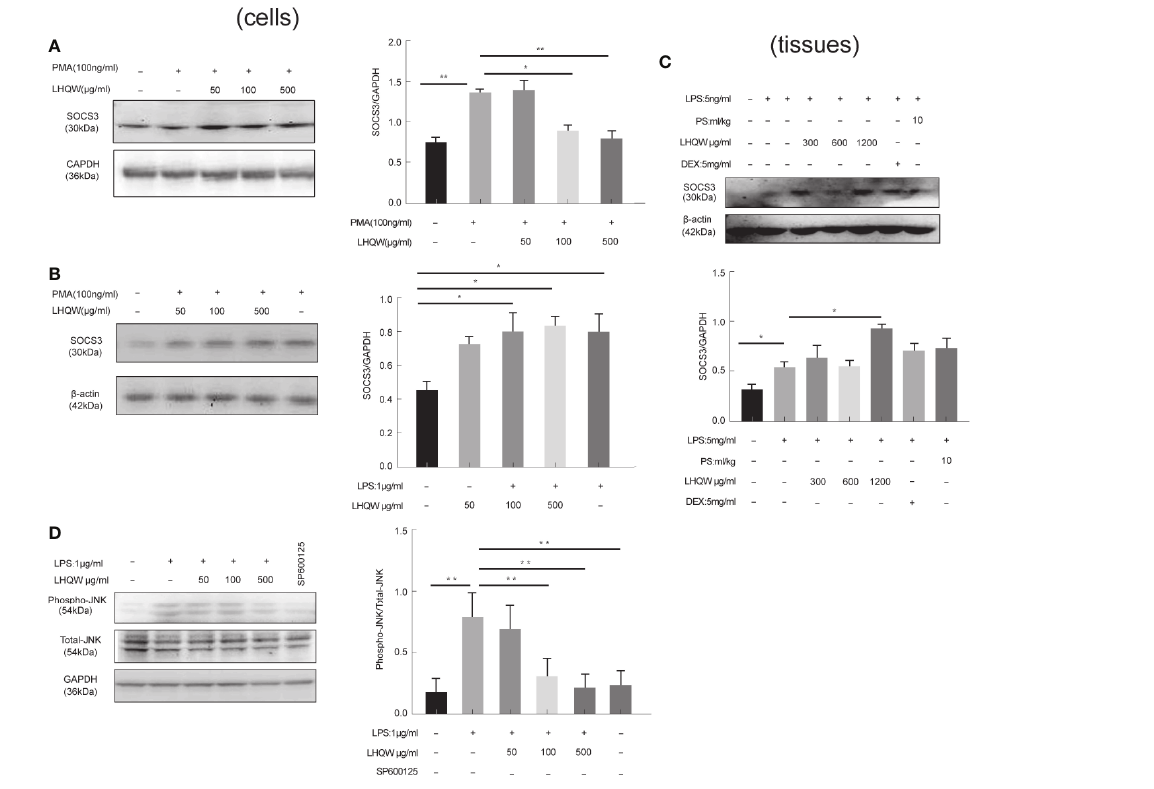
FIGURE 5 | Lian Hua Qing Wen capsule (LHQW) speci fi cally inhibited endoplasmic reticulum stress (ERS) through c-Jun N-terminal kinase (JNK) pathway activation. Bronchoalveolar lavage fl uid (BALF) samples were centrifuged, and pulmonary macrophages were isolated with the adherent method. THP1 cells were fi rst induced by PMA to differentiate into macrophages, and subsequently treated with LHQW and LPS for another 24 h. RAW 264.7 cells were also treated with LHQW and LPS for 24 h. (Togno-Peirce et al., 2013). In the cells, (A, B) LHQW enhanced SOCS3 expression in (A) THP1 cells, (B) RAW 264.7 cells by utilizing western blot. (C) LHQW decreased phospho-JNK expression by western blot analysis. In the tissues, (D) LHQW enhanced the translation of SOCS3 in alveolar macrophages. The data was presented as the mean ± S.E.M. of three independent experiments. # P < 0.05 vs. the NC group. * P < 0.05, ** P < 0.01 vs. the LPS group. LHQW-L: 50 m g/ml; LHQW-M: 100 m g/ml; LHQW-H: 500 m g/ml; TM,